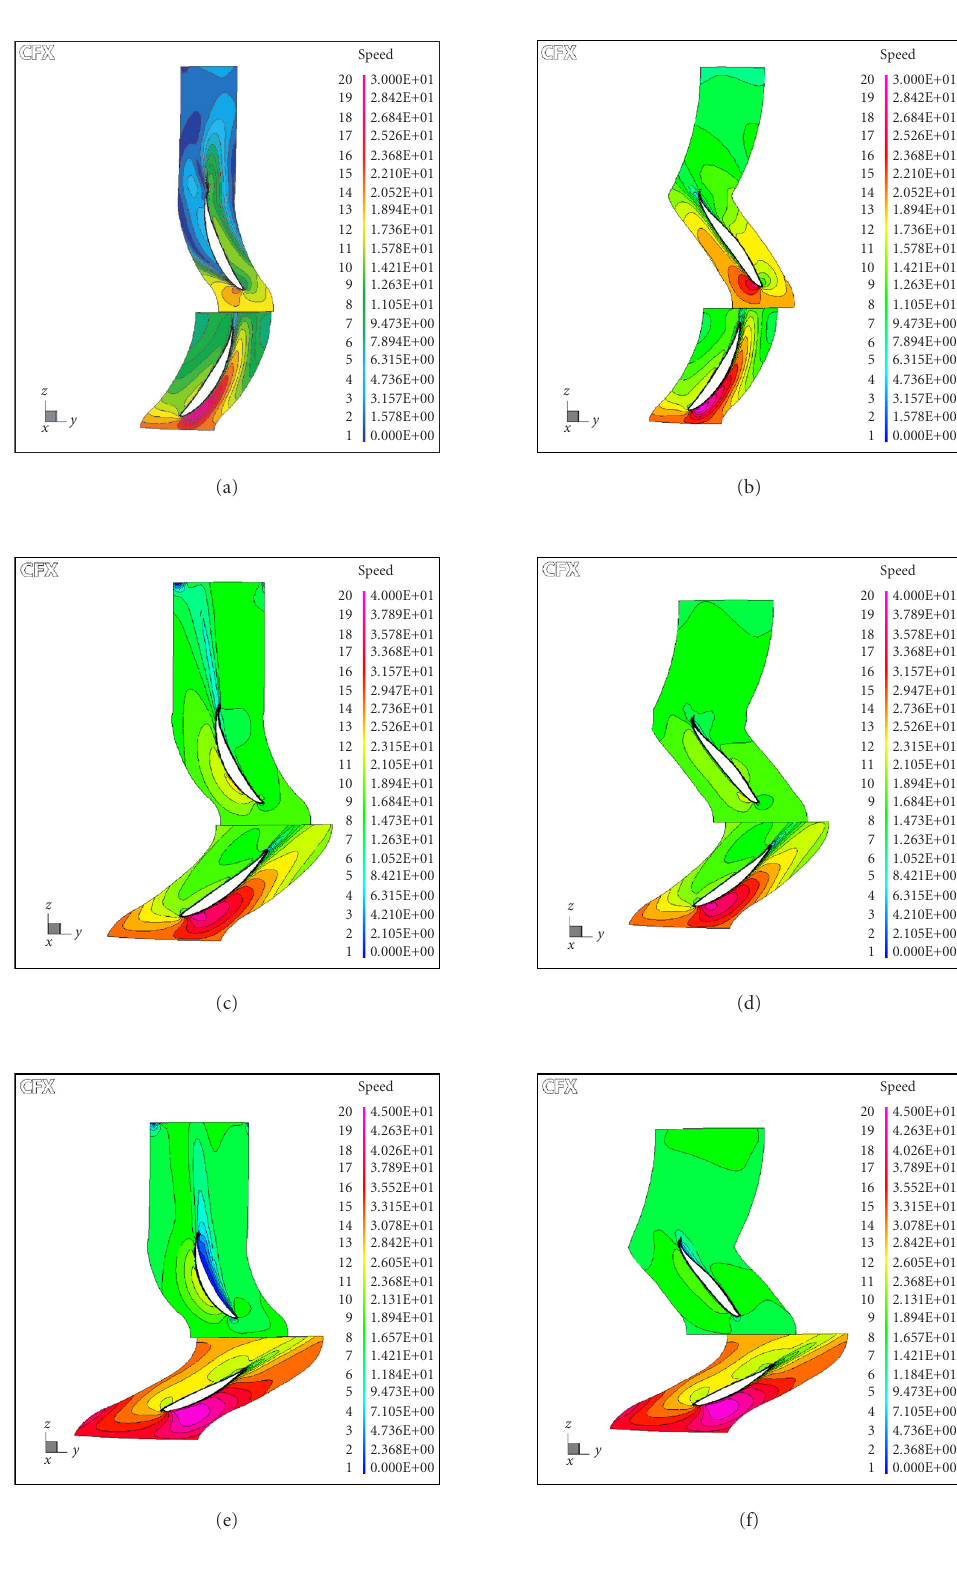
Figure 8: Comparison between the velocity field of the original configuration (left) and the optimized one (right), relatively to three sections, placed on 10, 50, and 90% of the blade